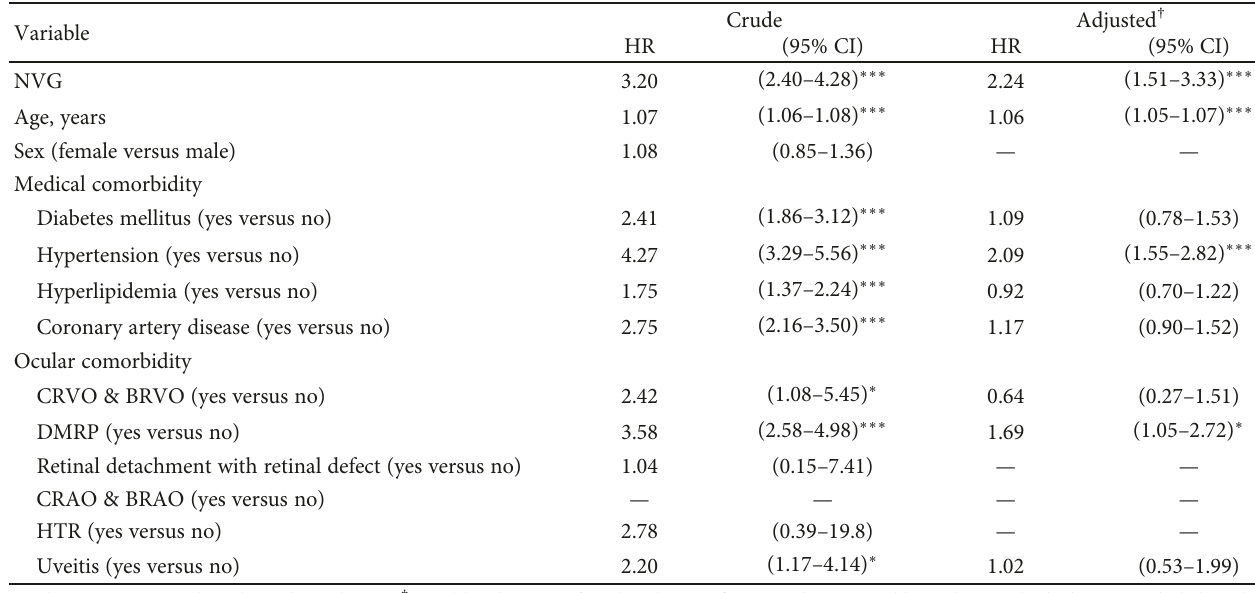
Table 3: Hazard ratios of ischemic stroke strati fi ed by age and comorbidities in the univariable and multivariable Cox regression models.